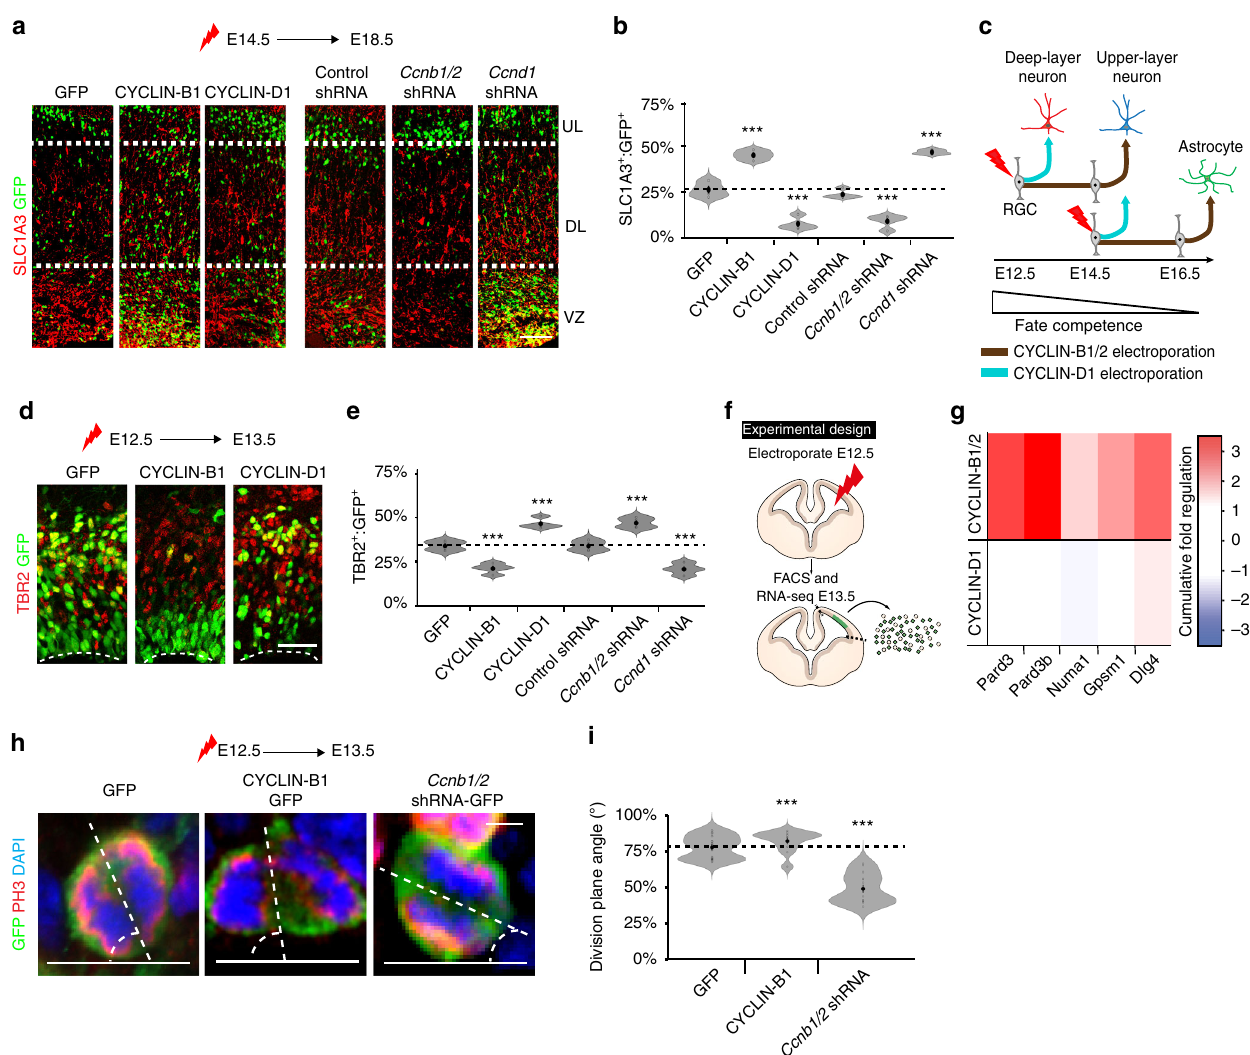
Fig. 7 CYCLIN-B1/2 and CYCLIN-D1 regulate cortical progenitor differentiation. a , b Analysis of cortical electroporation experiments performed at E14.5 and assayed at E18.5. Immunohistochemistry ( a ) and quanti fi cations ( b ) show expression of the astrocyte marker SLC1A3 (red) in cells electroporated with vectors expressing GFP (green) either alone or together with CYCLIN-B1, CYCLIN-D1, control shRNA , Ccnb1/2 shRNA or Ccnd1 shRNA ( n = 4 biological independent experiments). P -values SLC1A3 expression (vs. GFP); CYCLIN-B1 4.08e-4, CYCLIN-D1 4.34e-4, Ccnb1/2 shRNA 6.66-4, Ccnd1 shRNA 9.08e- 4). c Schematic model summarising electroporation experiments conducted in E12.5 and E14.5 cortices, in which CYCLIN-B1/2 and CYCLIN-D1 levels were manipulated. Brown arrows represent trajectories followed by CYCLIN-B1/2 electroporated cells and blue arrows represent trajectories followed by CYCLIN-D1 electroporated cells. d , e Analysis of cortical electroporation experiments performed at E12.5 and assayed at E13.5. Immunohistochemistry ( d ) and quanti fi cations ( e ) show expression of TBR2 (red) in cells electroporated with vectors expressing GFP (green) either alone or together with CYCLIN- B1, CYCLIN-D1, control shRNA, Ccnb1/2 shRNA or Ccnd1 shRNA. ( n = 4 biological independent experiments). P -values TBR2 expression (vs. GFP); CYCLIN- B1 2.19e-4, CYCLIN-D1 8.14e-4, Ccnb1/2 shRNA 6.1 – 4 and Ccnd1 shRNA 8.61e-4. f Schematic of cortical cells electroporated with vectors expressing GFP (green) either alone or together with CYCLIN-B1, CYCLIN-D1, Ccnb1/2 shRNA or Ccnd1 shRNA at E12.5 were isolated by FACS, and processed for RNA-seq at E13.5. g Assessment of the cumulative effect of CYCLIN-B1 or CYCLIN-D1 overexpression and knockdown on genes promoting symmetric divisions. h Immunohistochemistry of E13.5 cortices showing GFP expression (green), PH3 (red) and DAPI (blue) in mitotic cells following electroporation with vectors expressing GFP ( n = 10 biological independent experiments) either alone or together with CYCLIN-B1 ( n = 15 biological independent experiments) or Ccnb1/2 shRNA ( n = 14 biological independent experiments) at E12.5. White stippled lines indicate the division plane angle measured for each mitotic cell. i Quanti fi cation of division plane analysis of electroporated cells described in ( h ). P -values division plane angle (vs. GFP); CYCLIN-B1 1.61e-4 and Ccnb1/2 shRNA 2.87 – 7. Scale bars represent 50 µ m in ( a ), 30 µ m in ( d ) and 2 µ m in ( h ). Violin plots are inset by rings corresponding to the individual data points, a fi lled dot at the group mean and a vertical line showing standard error. Stars indicate signi fi cant differences between indicated group and GFP based on two-tailed t tests, with *** P < 0.001. Source data are provided as a Source Data fi